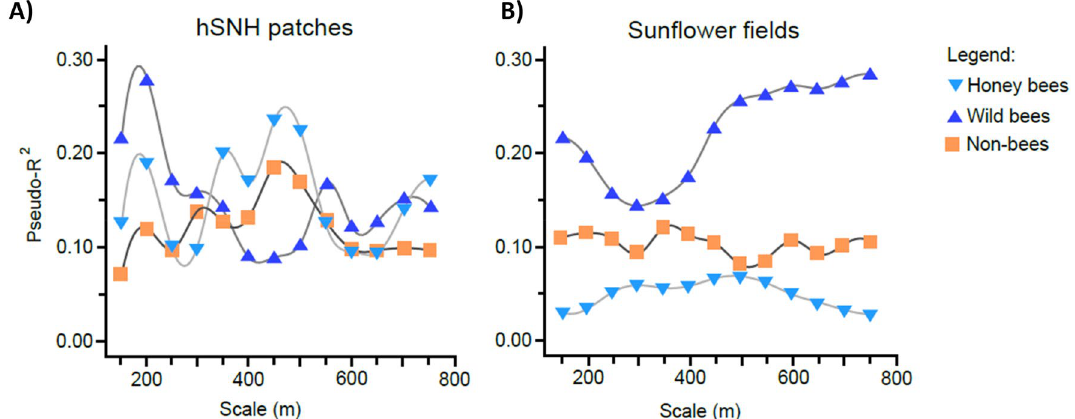
Figure 2. Explanatory power (= Pseudo-R 2 -values) of the Poisson GLMMs from Tables S4–S6, for ( A ) hSNH patches and ( B ) sunflower fields over 13 spatial scales (150–750 m). Trend lines were fitted among the points to make changes in the trend of the Pseudo-R 2 -values more apparent. The three studied pollinator groups are marked with different